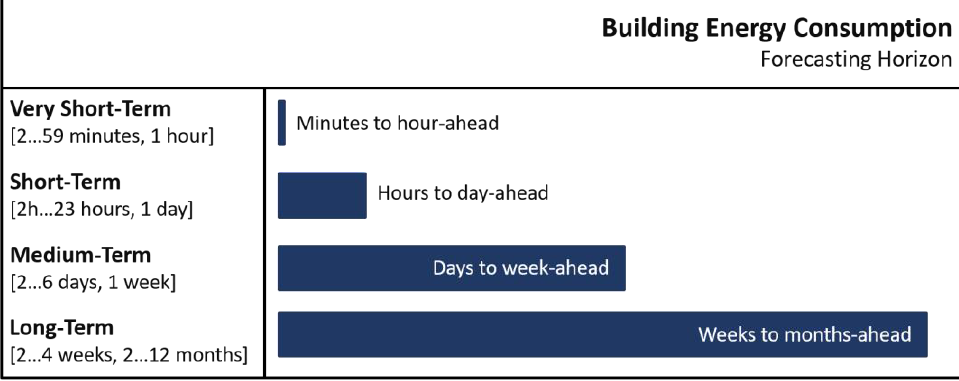
Figure 3. Building energy consumption forecasting horizon.